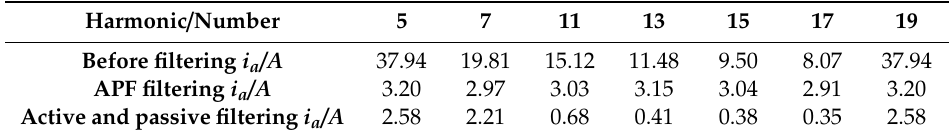
Table 2. THD of odd harmonic before and after filter.